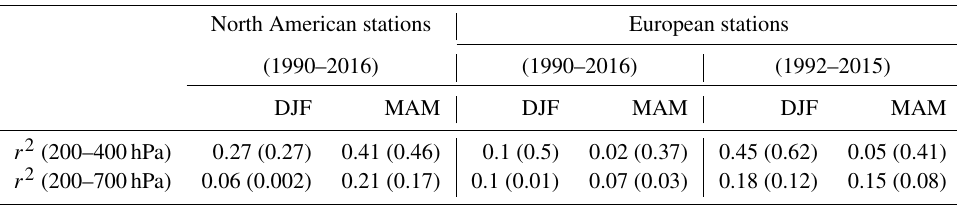
Table 3. Variance explained ( r 2 ) of ozone between 200 and 400hPa, 200 and 700hPa in observations and simulations. The numbers in parentheses are variance explained for